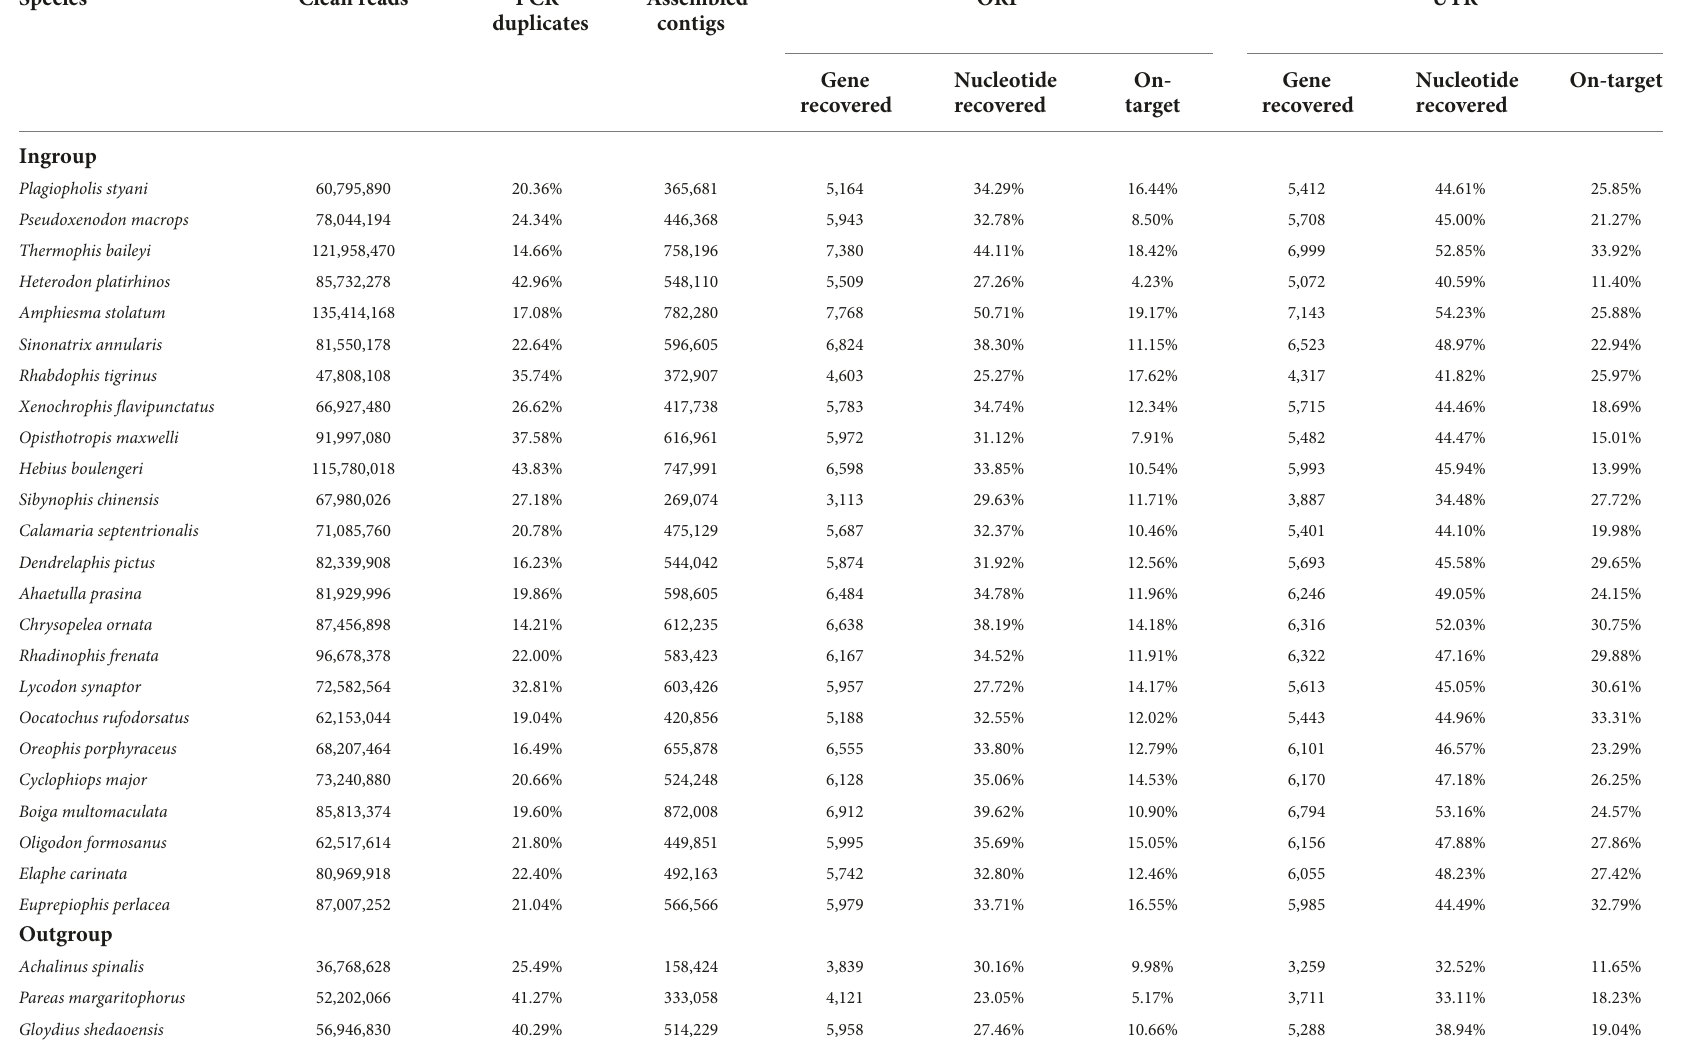
TABLE 2 Capture and sequencing results and detailed information from the bioinformatic pipeline for each sample. Species Clean reads PCR